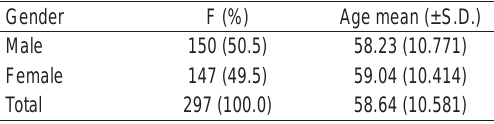
TABLE 1. Frequency among gender of study